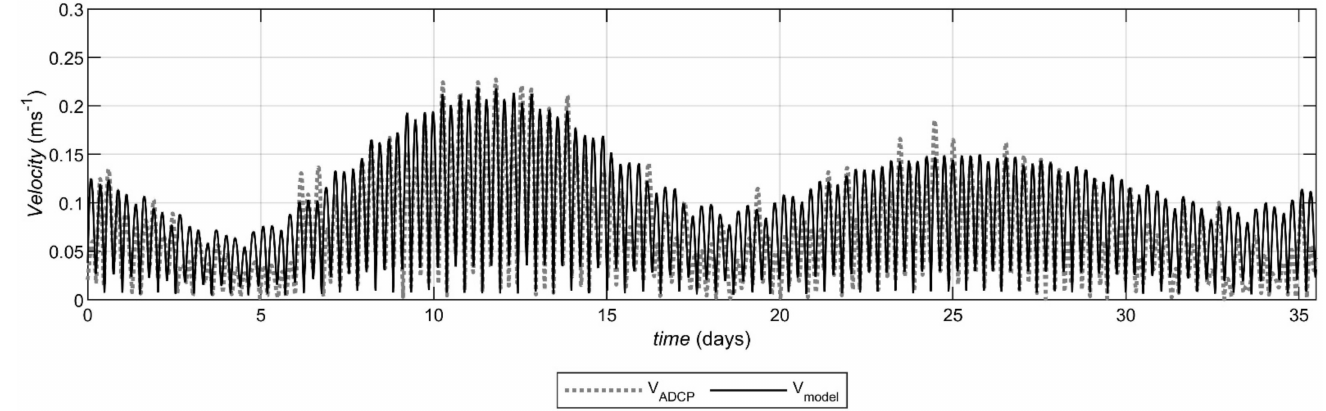
Figure 8. Comparison between the magnitude of the flow velocity registered by the ADCP (dots) and computed by the numerical model (continuous line).